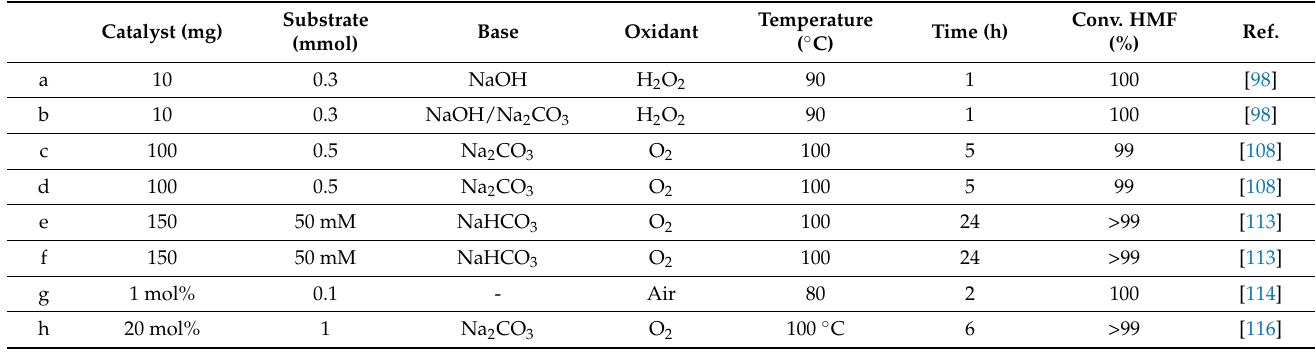
Table 4. Catalytic conditions for the different catalysts of Figure 5 in the HMF